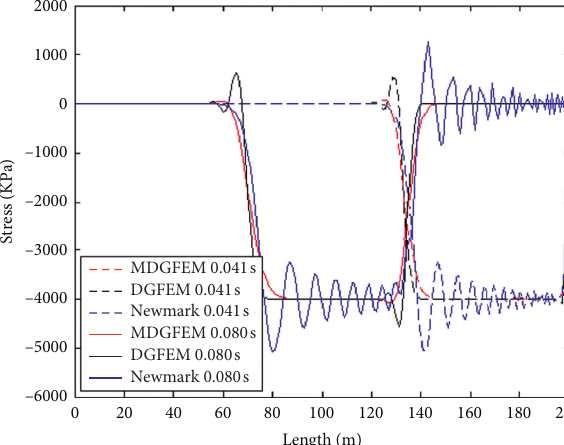
Figure 1: Model of example 1.